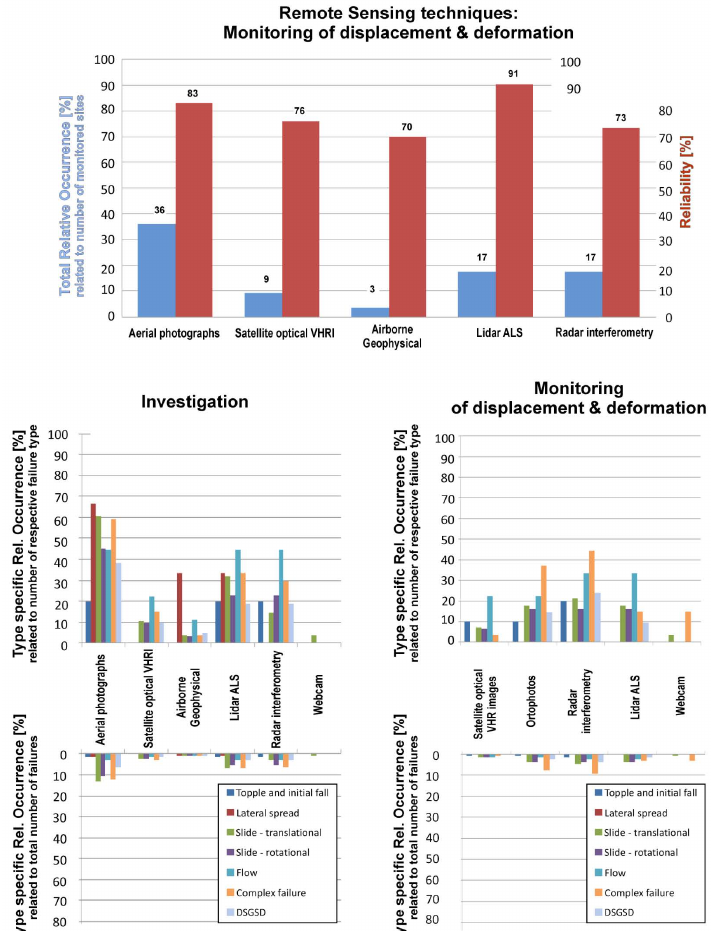
Fig. 8. Review of total relative occurrence, reliability and type-specific relative occurrence of the remote-sensing data applied for the inves- tigation or monitoring of the case